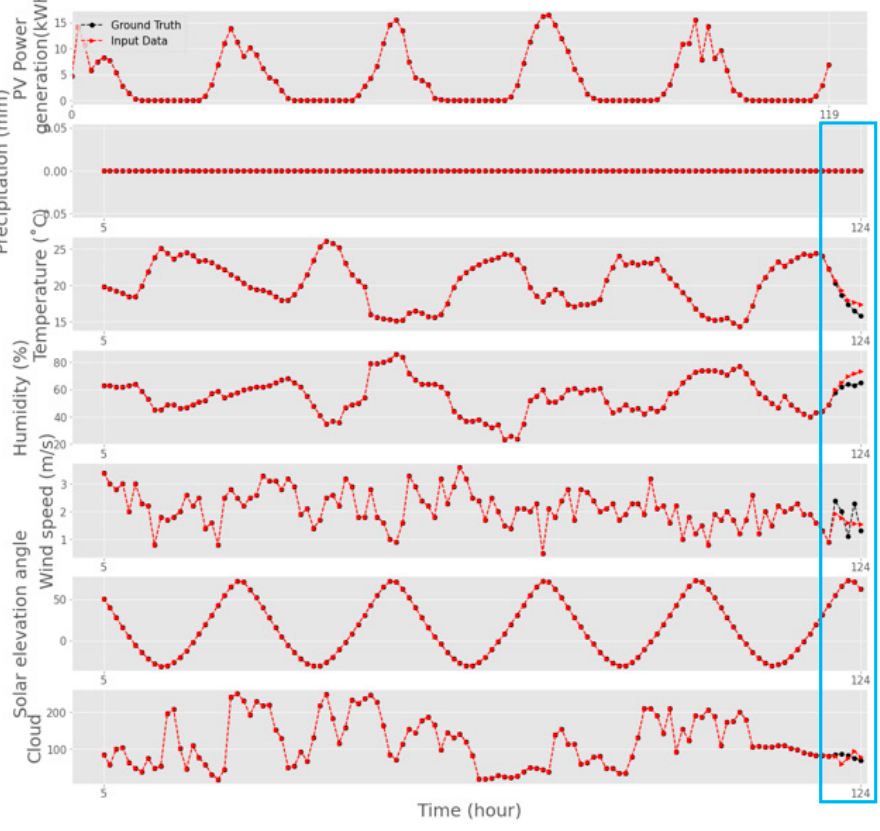
Figure 10. Example of Input data for the testing phase.